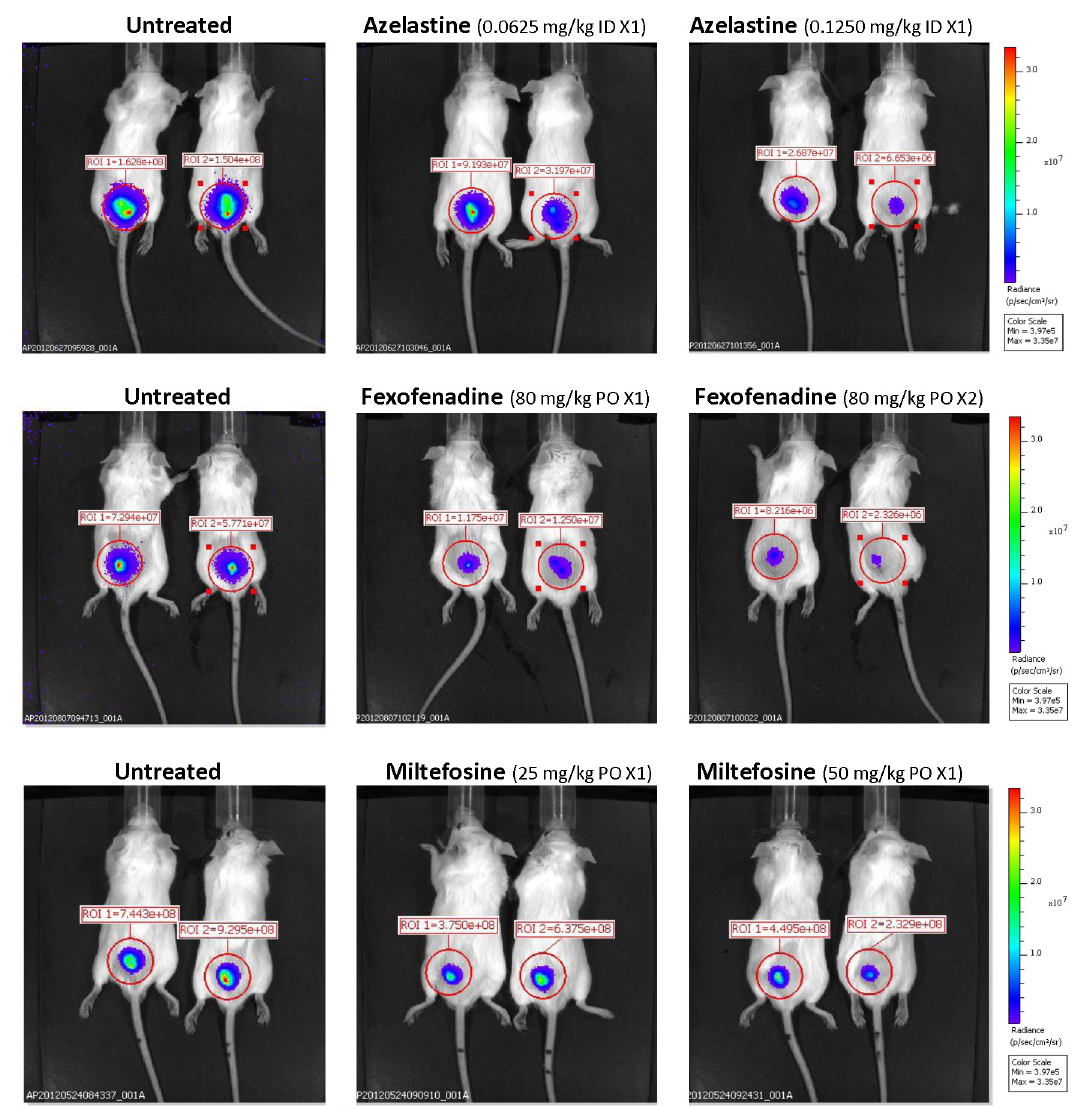
Fig 7. Representative IVIS images of mice treated for 10 days with different schedules and doses of azelastine or fexofenadine and the anti-leishmanial drug miltefosine.